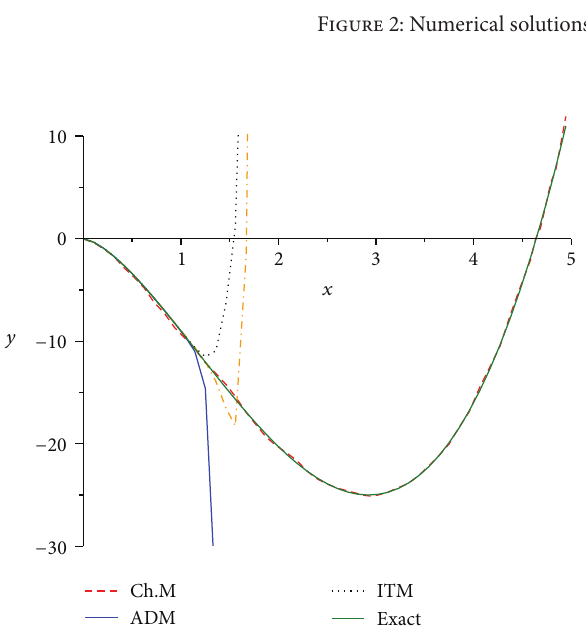
Figure 2: Numerical solutions of Example 1, for some values of 𝑚 .